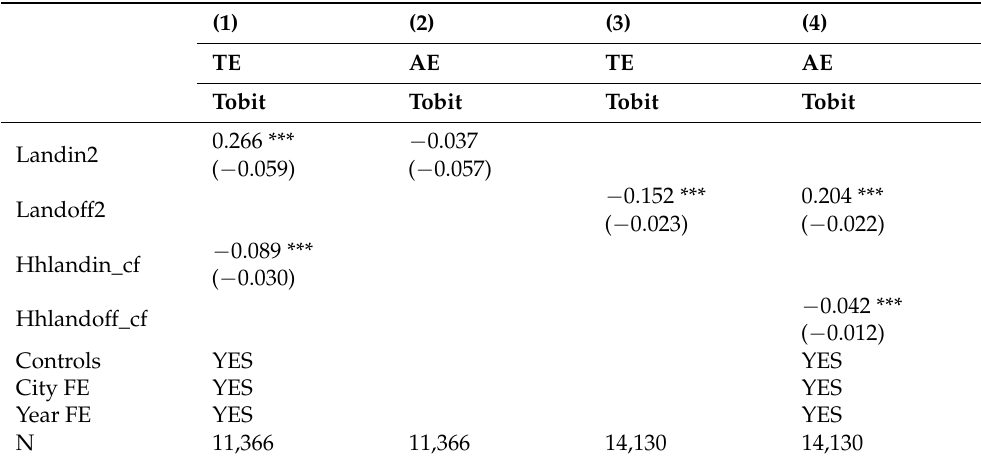
Table 7. Changing the control group of the key independent